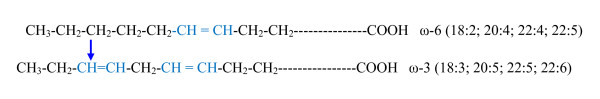
The fat-1 gene encodes an n-3 desaturase that converts n-6 to n-3 fatty acid.